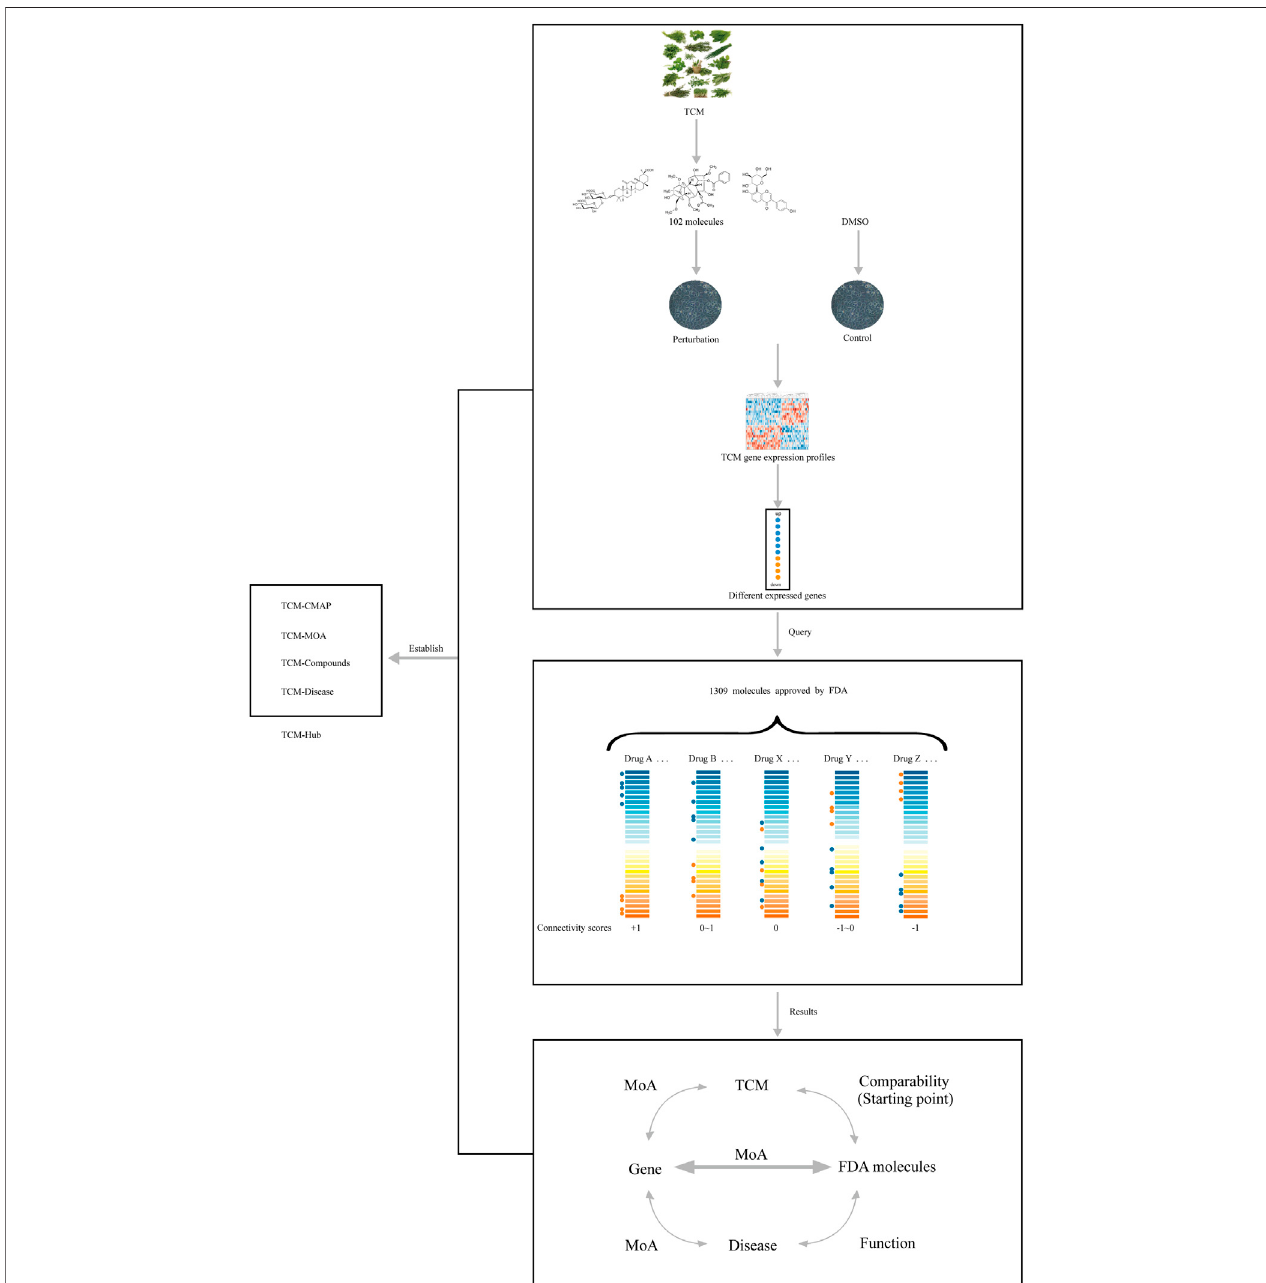
FIGURE 1 | Simpli fi ed overview of the principle and route of Connectivity Map applied in TCM. In the fi rst step, cells treated with 102 representative Chinese medicines molecularly were calibrated with the control group, and gene expression pro fi les were obtained by microarray technology. Then, different expressed genes were available to query the latest CMAP so connection scores were acquired with certain algorithm. Based on the results above, comparability between TCM and corresponding small molecules was the starting point. With that, the relationship between TCM, genes, and diseases has chance to be further analyzed. Finally, a TCM Hub database is established by integrating the